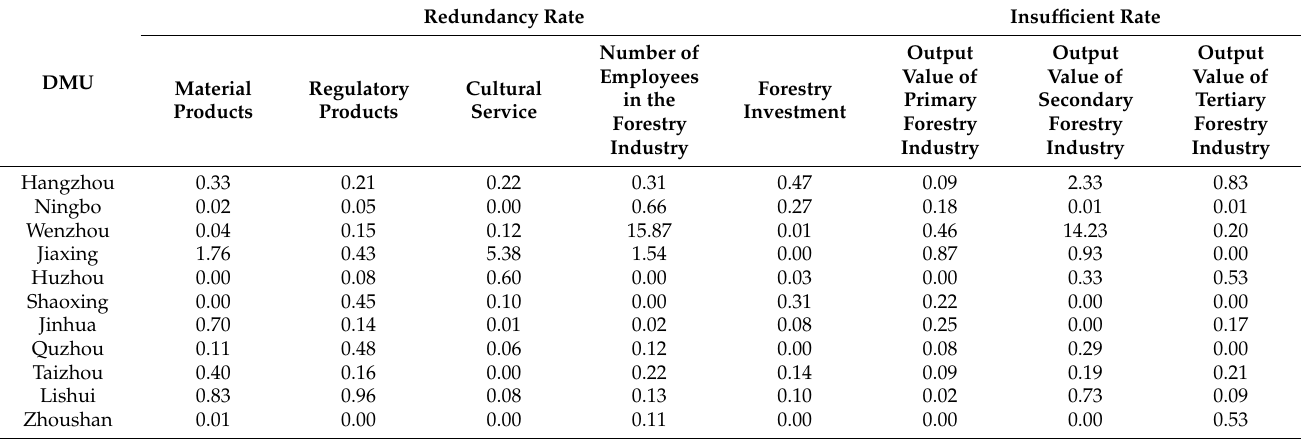
Table 7. Average annual input–output slack rate of cities in Zhejiang